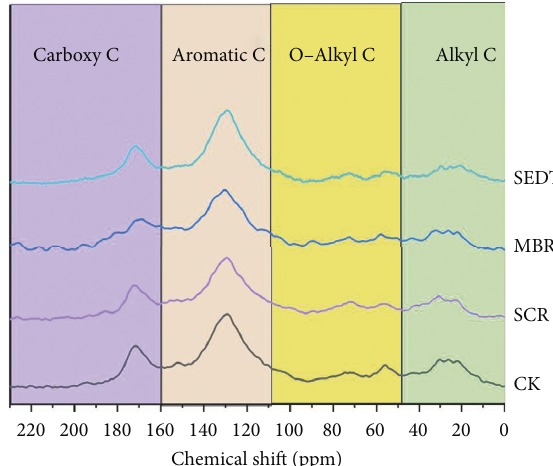
Figure 4: 13 C CPMAS NMR spectra of HA in different maize returning methods. Note. CK: no straw application; SCR: straw mulching; MBR: straw deep ploughing; SEDI: straw enrichment and deep incorporation. There were significant differences between different letters representing different treatments ( p < 0 . 05). Table 5: Relative intensity (%) of different chemical shift intervals from 13 C CPMAS NMR spectra of HA examined.